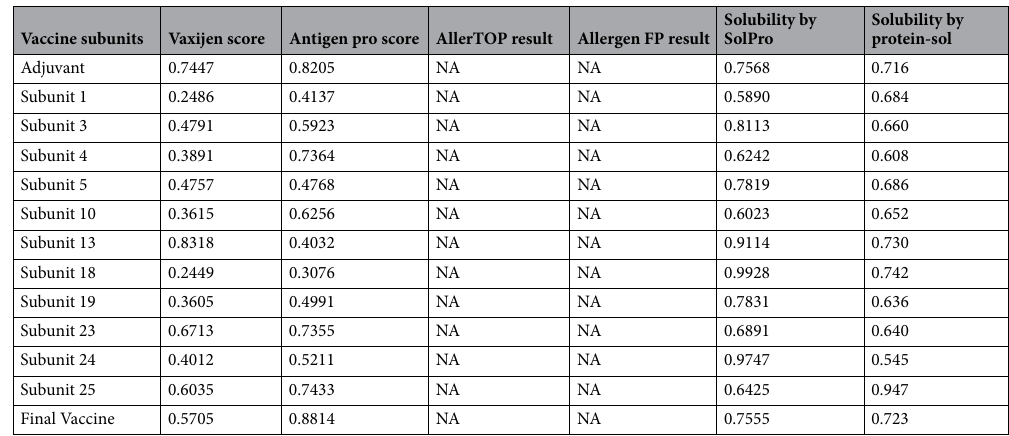
Table 9. Antigenicity, allergenicity and solubility Evaluation Results. NA: non-allergen. Higher Vaxijen and Antigen Pro scores suggest higher antigenicity. Higher SolPro and Protein-sol scores suggest higher solubility.